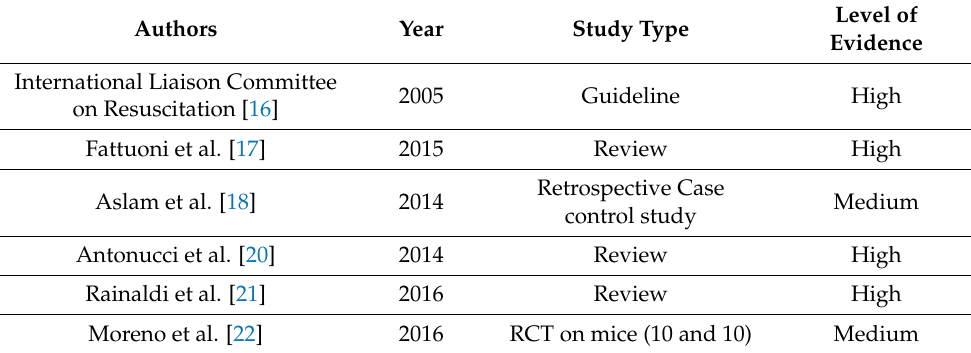
Table A1. Systemic research results on Microbial Translocation in Neonatal Hypoxic/Asphyxiating conditions.